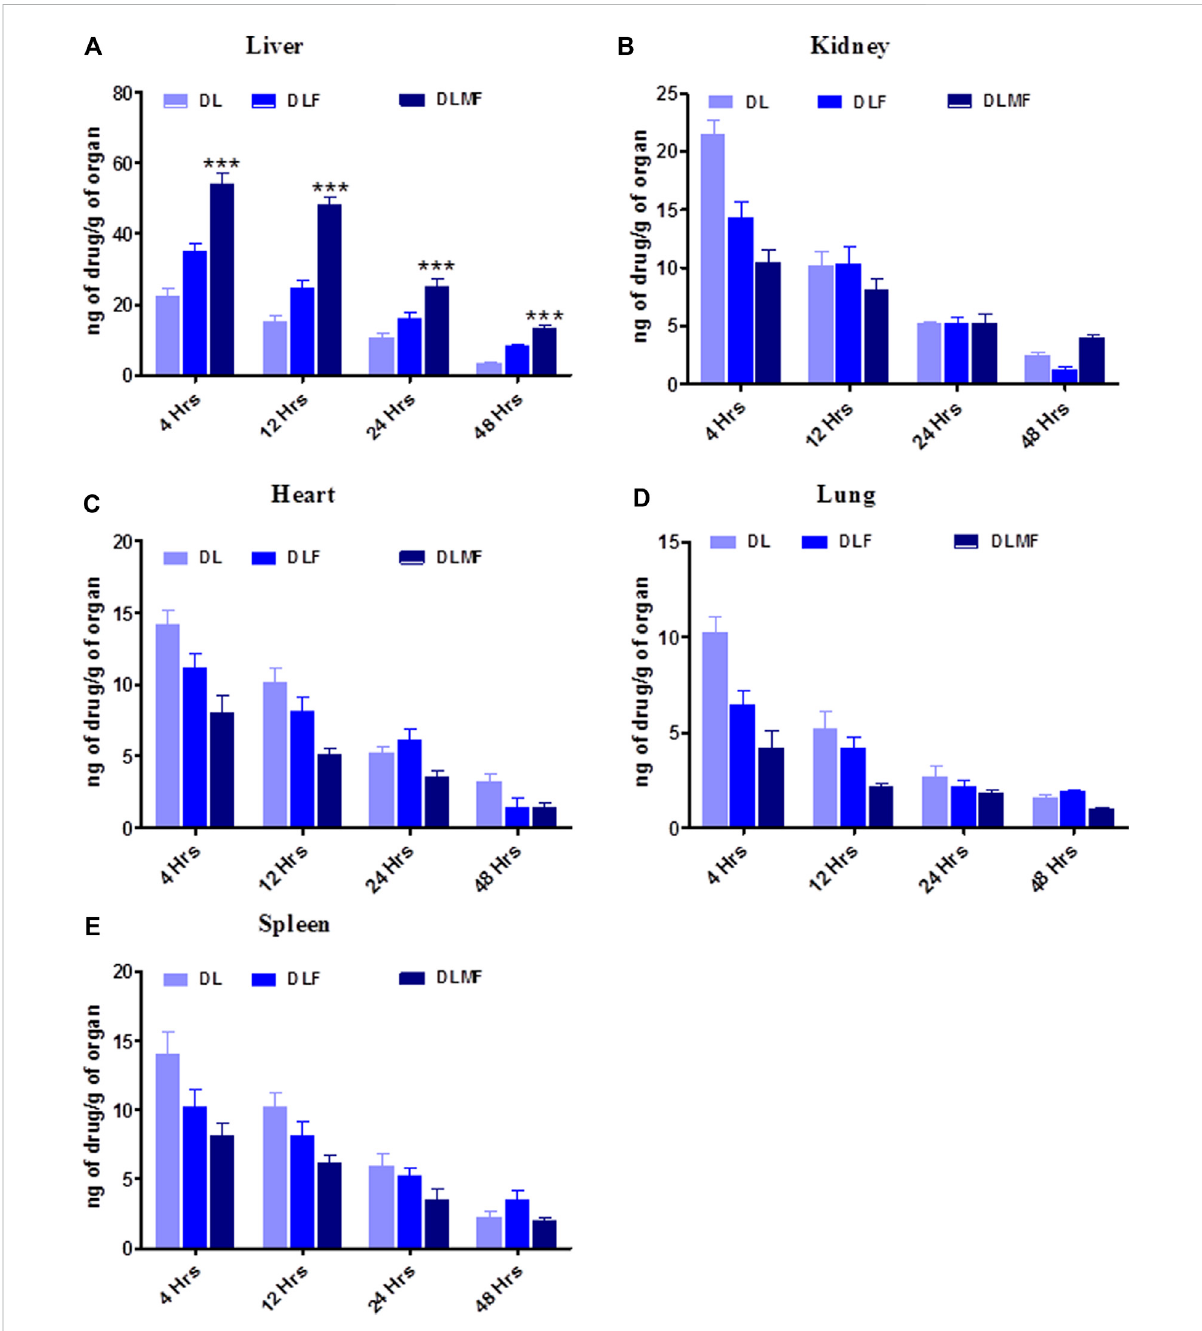
FIGURE 7 Bio-distribution of DL, DLF and DLMF In various organs. (A – E) are showed individual organ like, (A) Liver, (B) Kidney, (C) Heart, (D) Lung, (E)